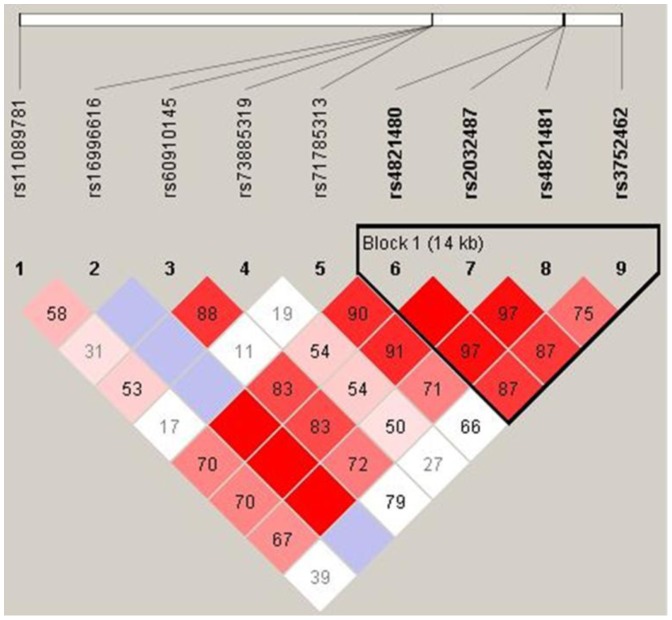
Linkage disequilibrium structure of MYH9 and APOL1 gene polymorphisms in 196 LN Brazilian patients.